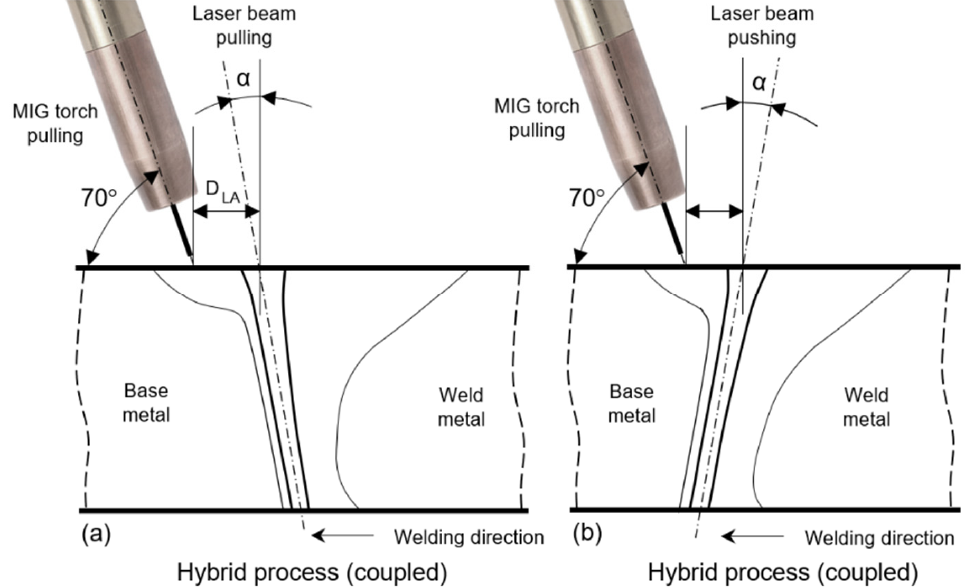
Figure 11. Process variation according to distance length between laser beam and arc source in case of leading arc (trailing laser) position. Hybrid process with ( a ) inclined pulling keyhole position and ( b ) inclined pushing keyhole position. D LA is the process distance between the laser beam axis and filler wire tip, α is the angle from laser beam axis to normal and taken as 10°.